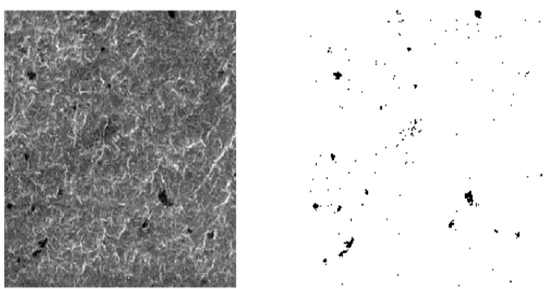
Figure 7. Low–high load fracture surface (420–520 MPa, n 1 /N 1 = 0.25) binarization.